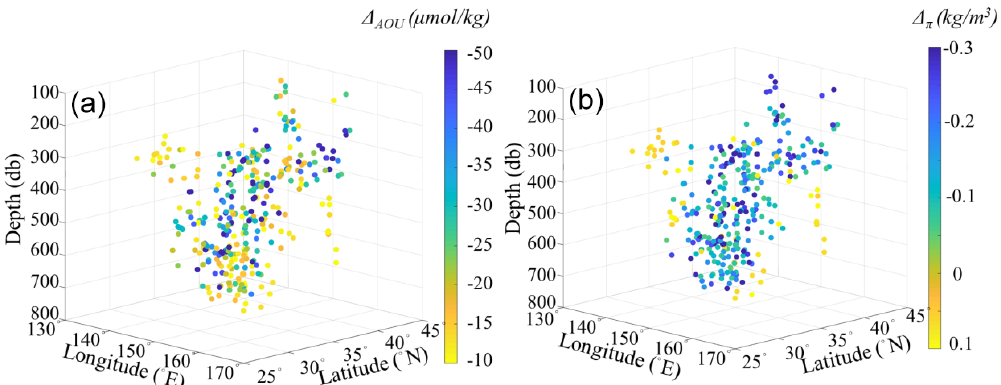
Figure 7. Vertical spatial distribution of the detected subduction patches in the western North Pacific, color-coded by the magnitudes of the subduction strengths in terms of the AOU anomaly (a) and π anomaly (b)